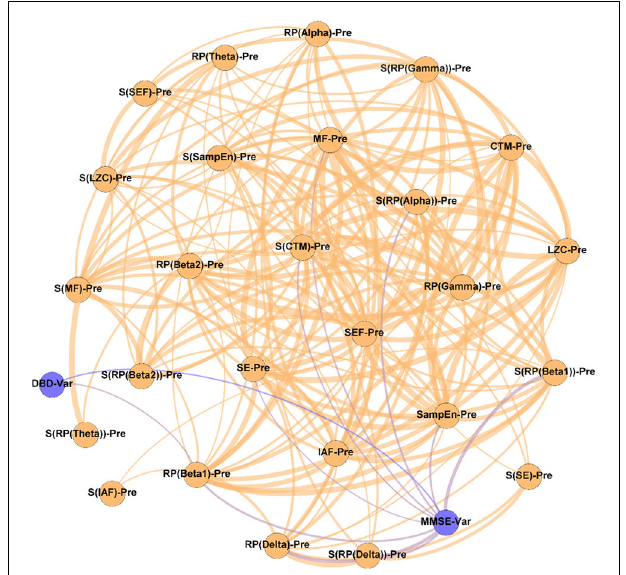
FIGURE 6 | Prediction network, showing the ability of the assessed neurophysiological parameters to predict the outcome of the NPT. The “Var” suffix, which appears associated with DBD and MMSE, means the variation of the parameters under study during the NPT (i.e., Parameter Post − Parameter Pre ). Wider edges correspond with stronger associations. Nodes corresponding to cognitive and behavioral parameters are shown in blue, while nodes of neurophysiological parameters are shown in